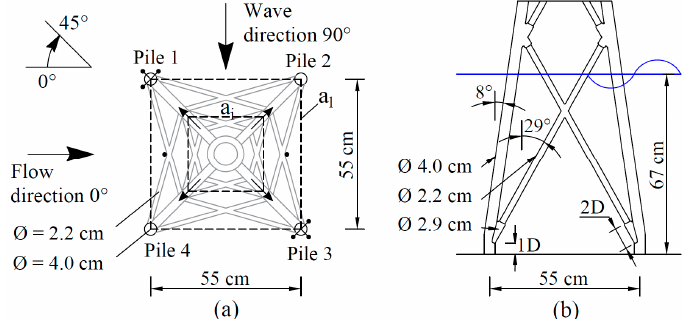
Figure 2. Schematic view of the jacket model ( a ) plan view on the model, including dimensions, the mounted echo sounding transducer, the reference structure footprint a 1 and the increasing interrogation area a i to compute the erosion volume ( b ) side view of the model with dimensions, angles and water level, D = 4 cm.